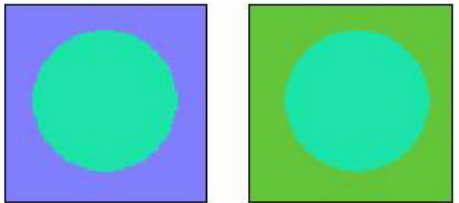
Fig. 4. The impact of color adjacency on the percep - tion of hue. The object’s color is perceived as greener (warmer) on a green (warmer) background and